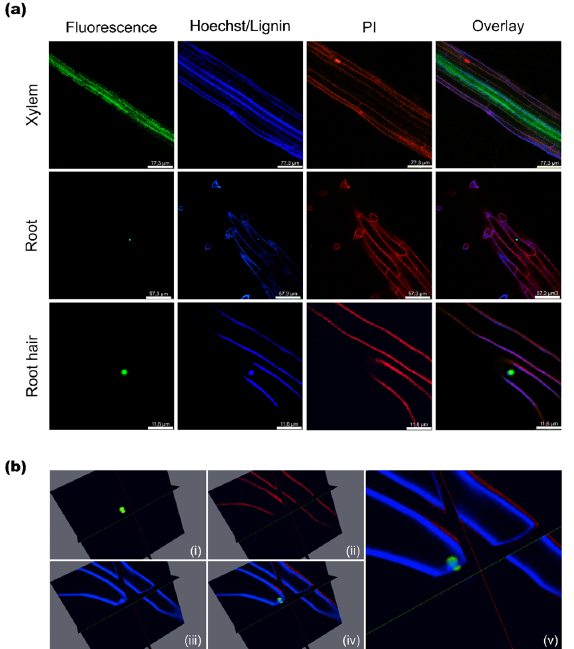
Figure 3. Subcellular localization of At SAH7 in 7-day-old roots in chimeric 35S: At SAH7-EYFP trans- genic plants after PI and Hoechst 33258 staining. ( a ) Confocal imaging of xylem, root and root hair tissues. ( b ) 3D imaging of a root hair expressing At SAH7. (i) Fluorescence; (ii) PI; (iii) Hoechst 33258; (iv) Overlay; (v) Zoom of (iv) in the area of the signal.